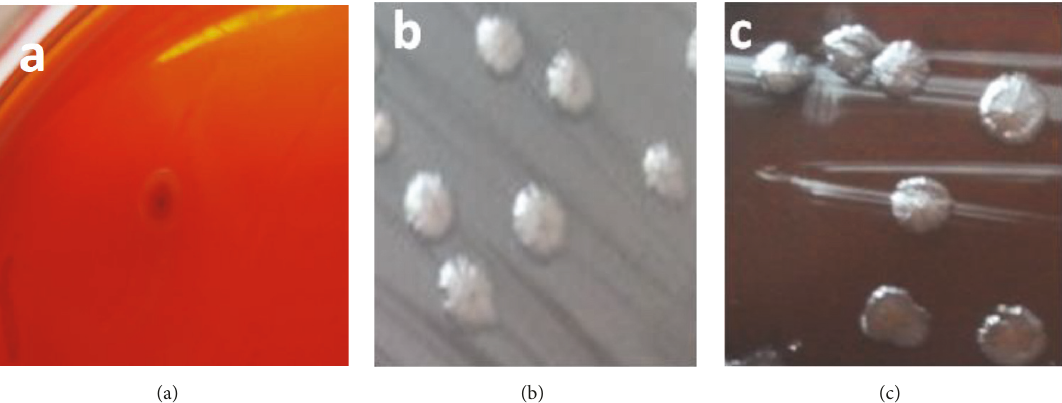
Figure 1: The morphotypes of S . Hadar before and after irradiation: (a) untreated black colonies; (b) bdar morphotype (1kGy); and (c) rdar morphotype (2kGy).